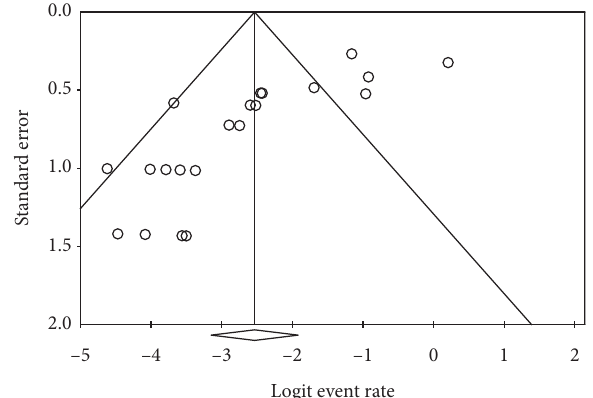
Figure 4: Funnel plot of studies regarding the proportion of ocular manifestations.